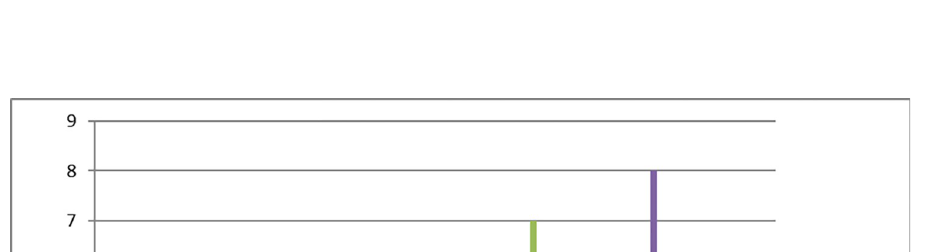
Fig 2. Prevalence of FLA, Acanthamoeba , Vahlkampfiidae ( Naegleria -like), and mixed genera in tap and tank water samples.